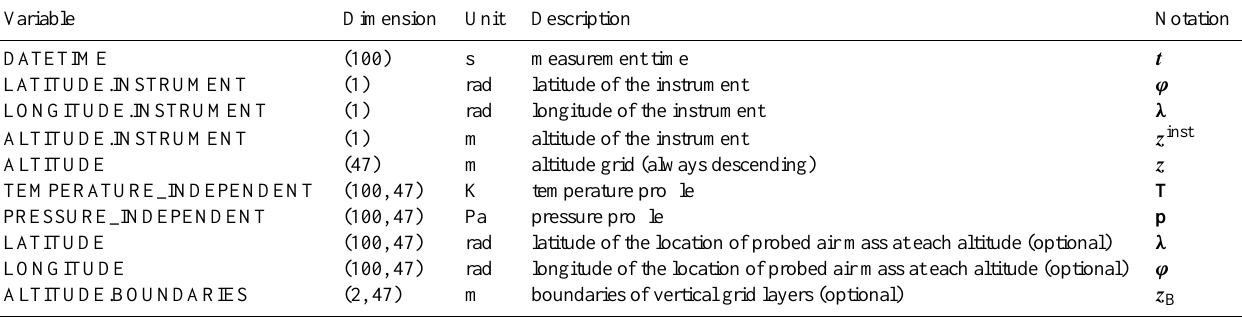
Table 2. List of GEOMS variable names common for all GEOMS templates (dimensions are indicative for 100 measurements on a grid with 47 layers).